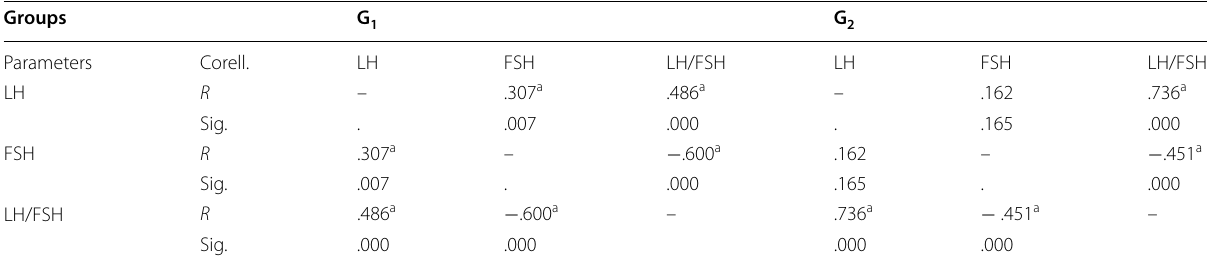
Table 3 Spearman’s rho coefficient corellation